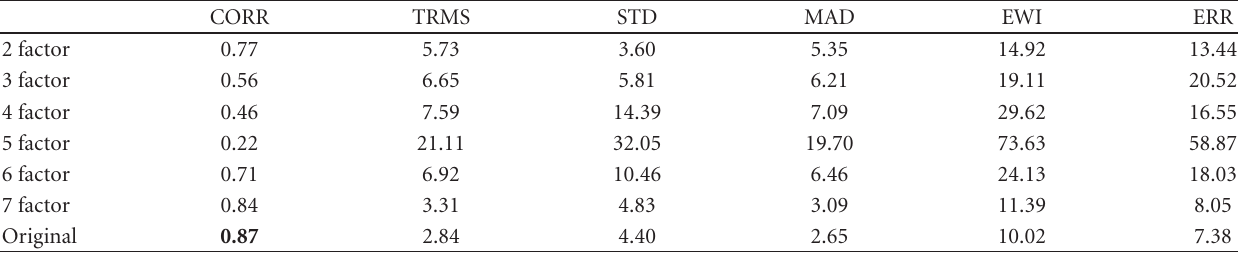
Table 3: Correlation and other analysis of data from